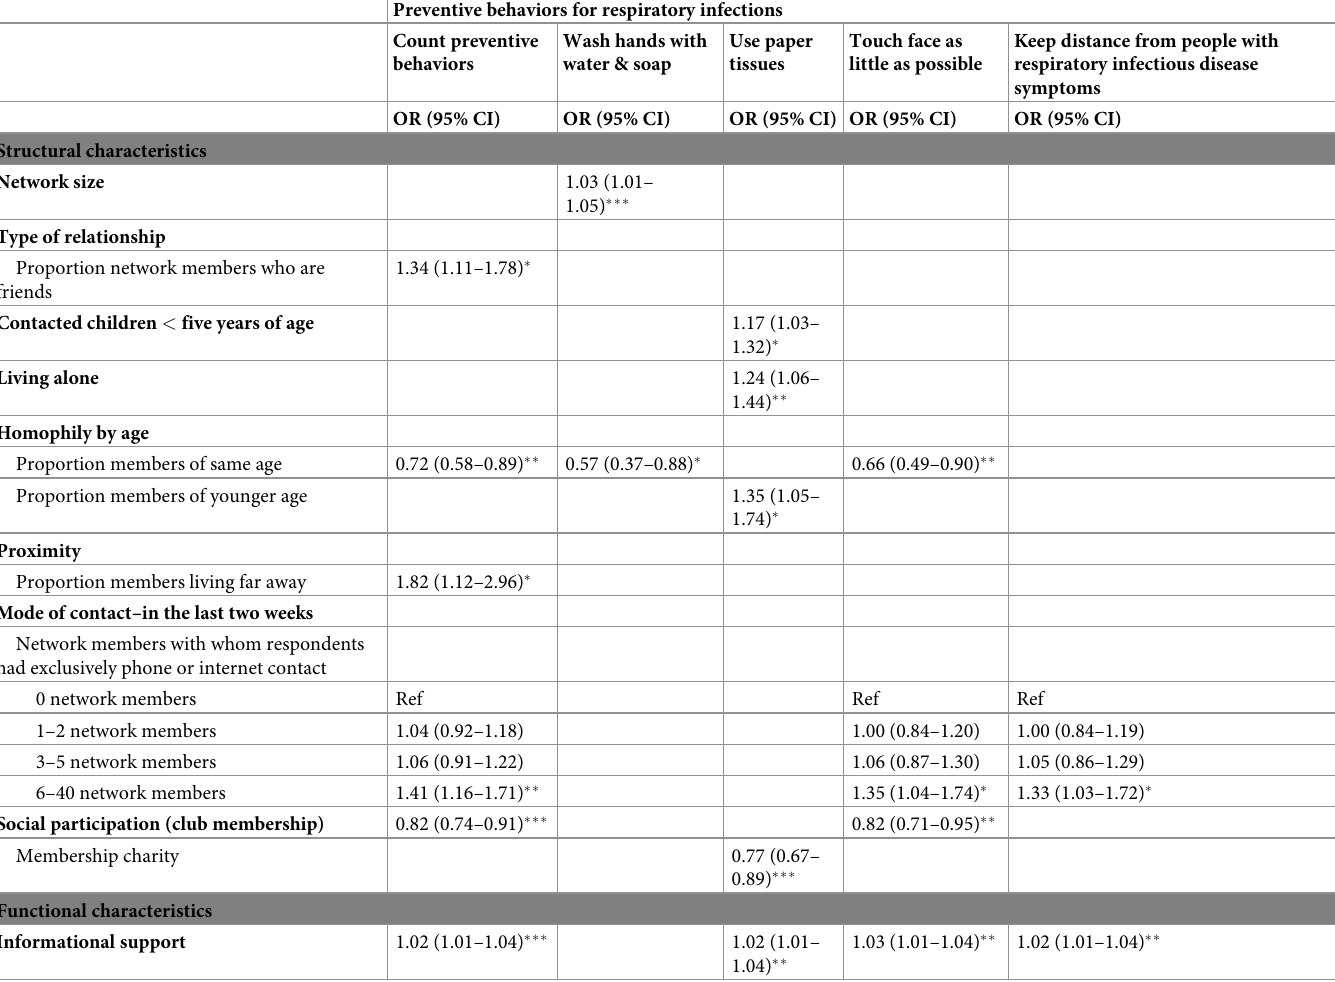
Table 4. Multivariate model II–independent associations between social network characteristics and preventive behaviors in SaNAE study population, adjusted for